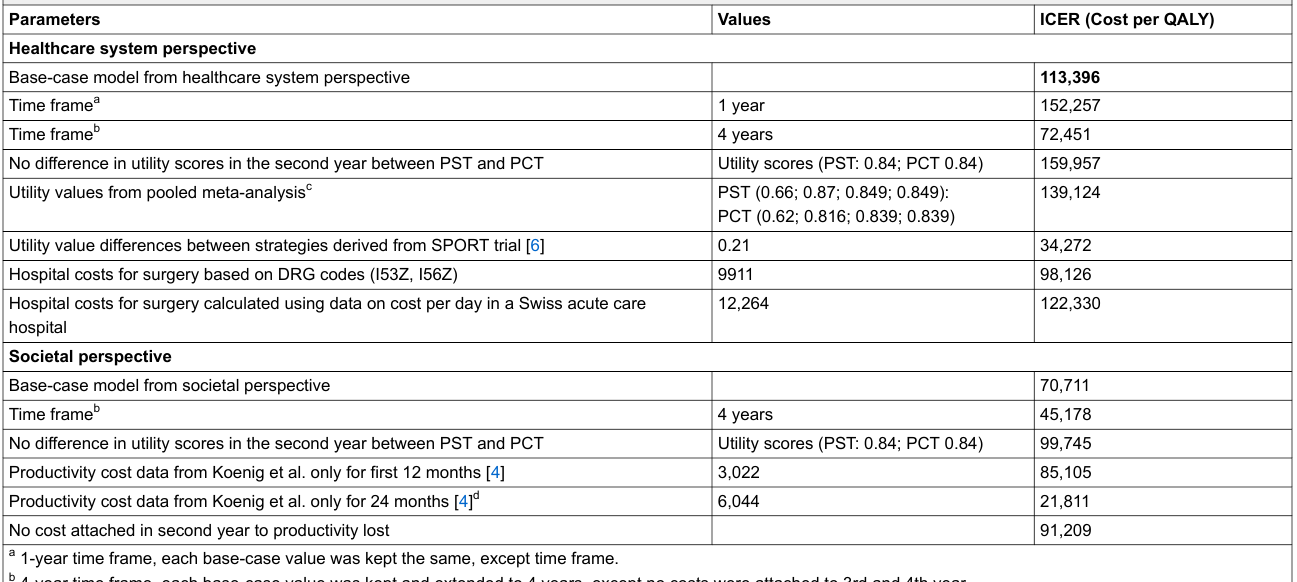
Table 3: Scenario analysis for the decision analytical model, comparing primarily conservative treatment (PCT) with primarily surgical treatment (PST). Parameters Values ICER (Cost per QALY) Healthcare system perspective Base-case model from healthcare system perspective